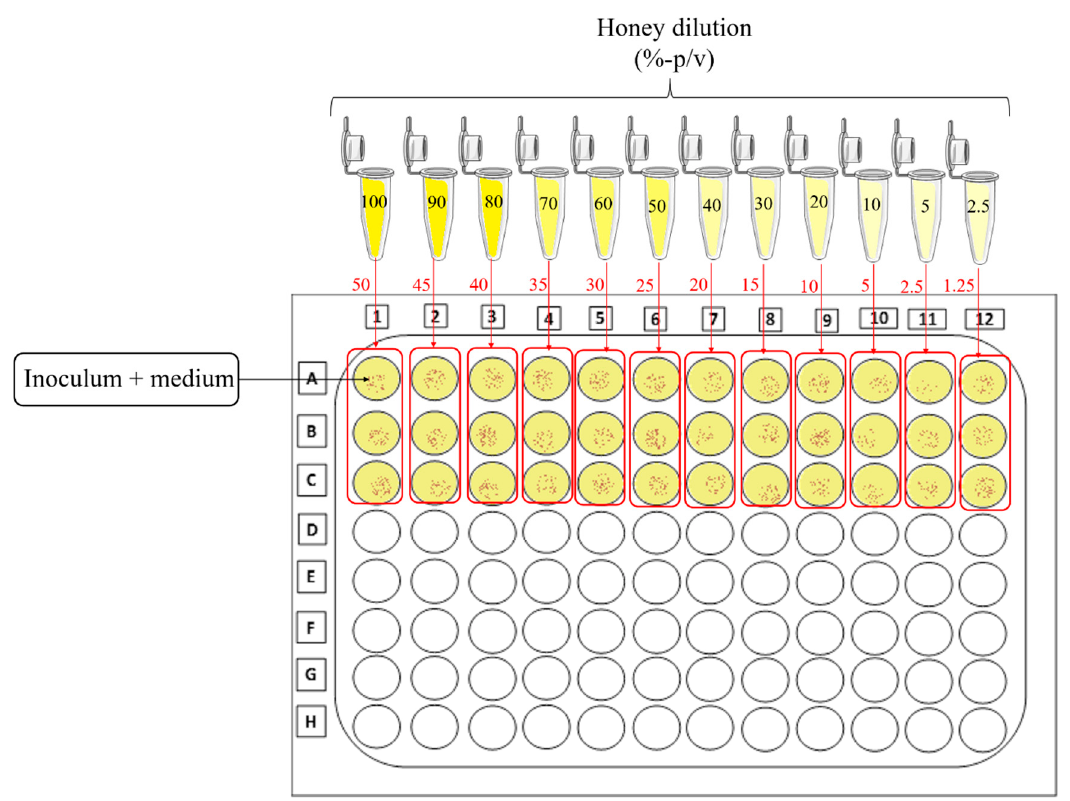
Figure 3. Schematic representation of the serial dilution of honey for antimicrobial testing. The honey sample should be diluted separately by preparing a solution with twice the concentration expected to be in the well of the microplate. After adding the diluted honey solution to the same amount of inoculum, the concentration will drop by half in the well. To obtain these concentrations, it is necessary to use the microplate horizontally, as demonstrated in the figure.